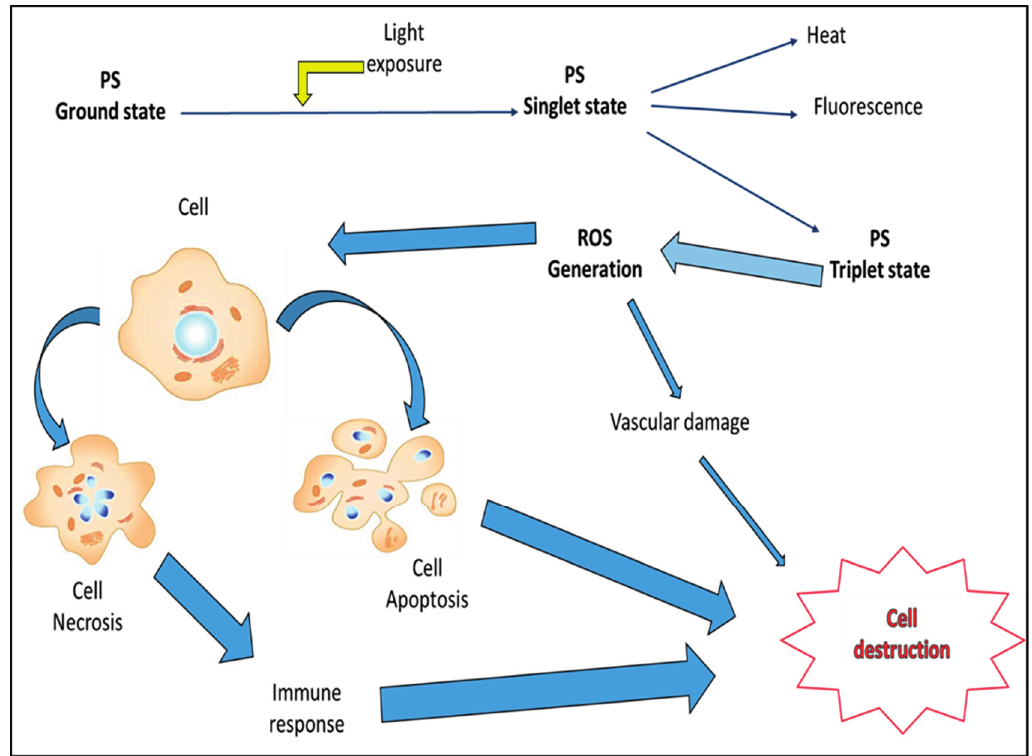
Figure 1. Photodynamic cancer therapy (PDT)-mediated cellular effects. Photosensitizer (PS) localizes in tumor cells and is converted from its ground to singlet state form through light activation. Singlet state PS can lose energy in form of heat or fluorescence, but an ideal photodynamic PS undergoes inter-system crossing and transforms into the triplet state form. Triplet state PSs with a long lifespan mediate reactive oxygen species (ROS) generation within cells. ROS induce cytotoxic effects (predominantly apoptotic and necrotic types of responses, with the exception of autophagy, which is more cytoprotecting than cytodamaging), causing cell damage and